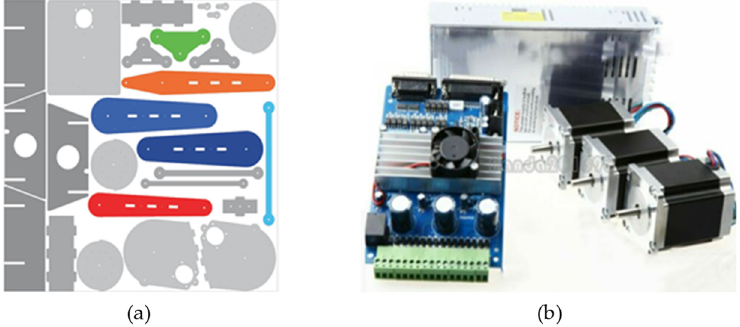
Figure 2. ( a ) Robotic arm parts for laser cutting; ( b ) Nema 23 stepper motors, driver, and power supply.